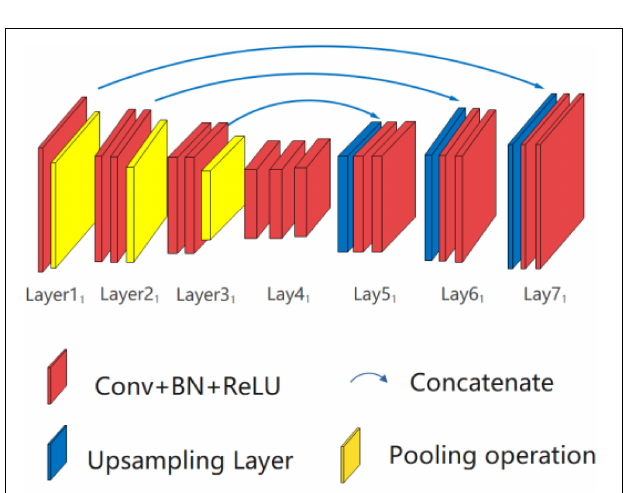
FIGURE 7 | Schematic diagram of U 1 path structure.